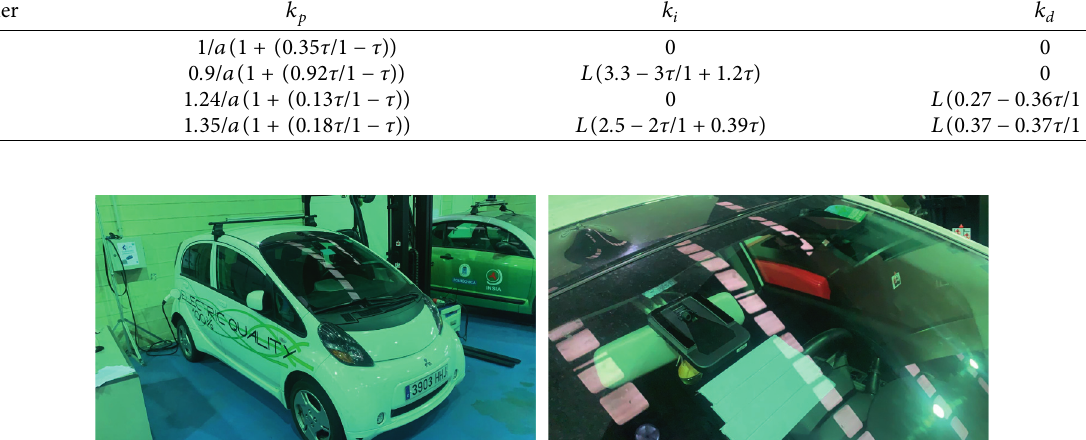
Figure 2: Autonomous electric vehicle used in real testing and light detection and ranging sensor (LiDAR) placed on the vehicle